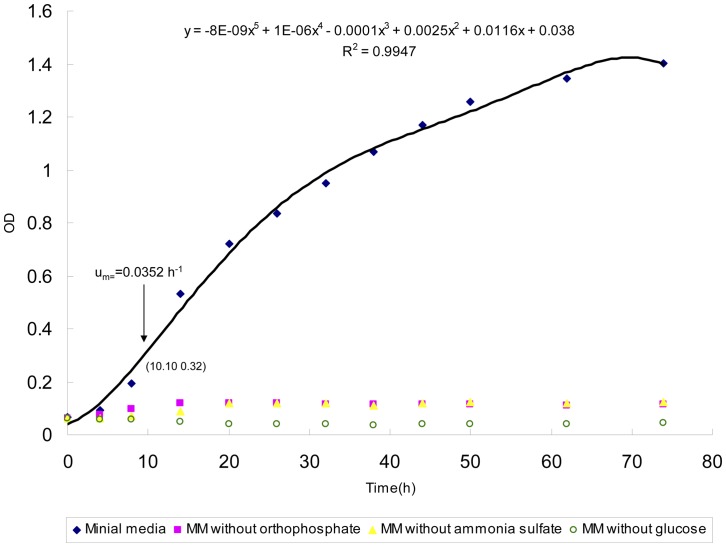
Experimental validation of the minimal media predicted in silico with the model iYL619_PCP.The composition of minimal media in experiment is as follows: glucose (20g/L), NH4SO4 (3g/L), KH2PO4(2g/L). The OD of culture media after inoculation was about 0.06.